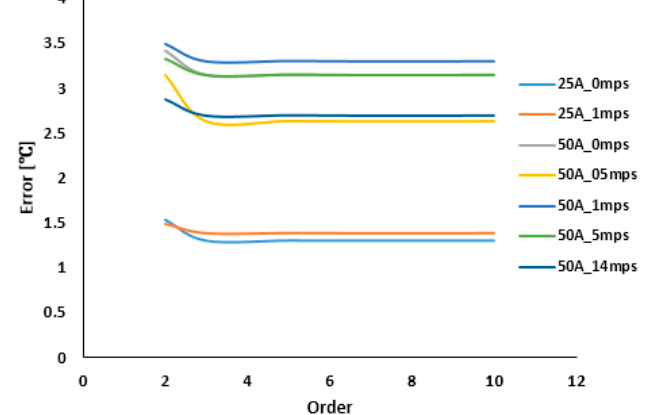
Figure 8. Maximum error vs. model order for collector–emitter voltage (VCE) method with calibration curve from average temperature in cooldown phase.